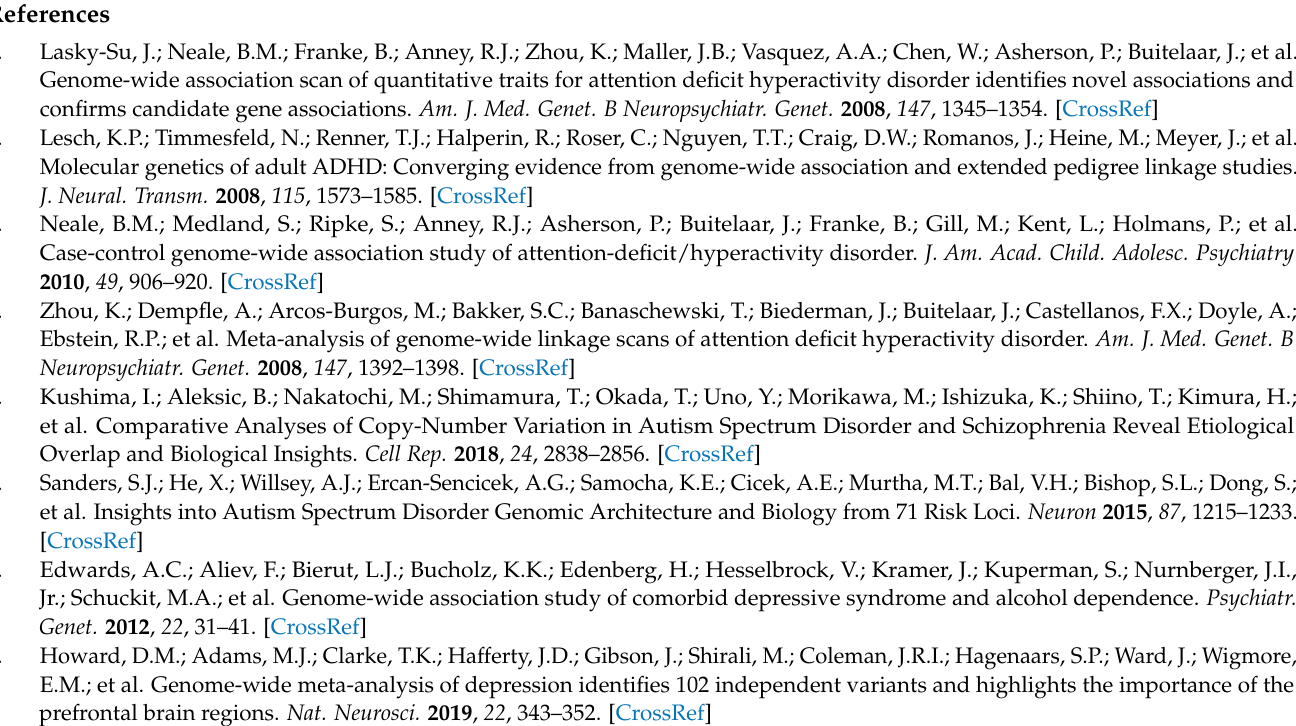
Table S2: rs2199430 genotype distribution in the adult ADHD and control sample; and Table S3: F-statistics for the Big Five personality traits with rs2199430 genotype as an independent variable in the aADHD